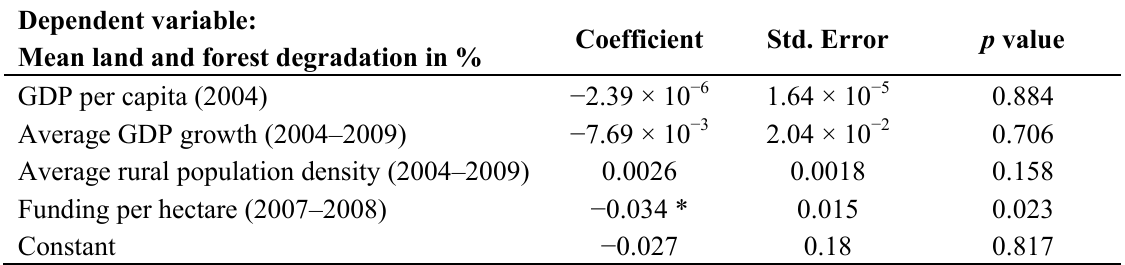
Table 3. Regression results for country-level independent